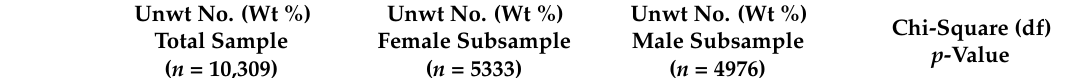
Table 1. Characteristics of the YRBS 2019 representative sample of U.S. high school students ( n =